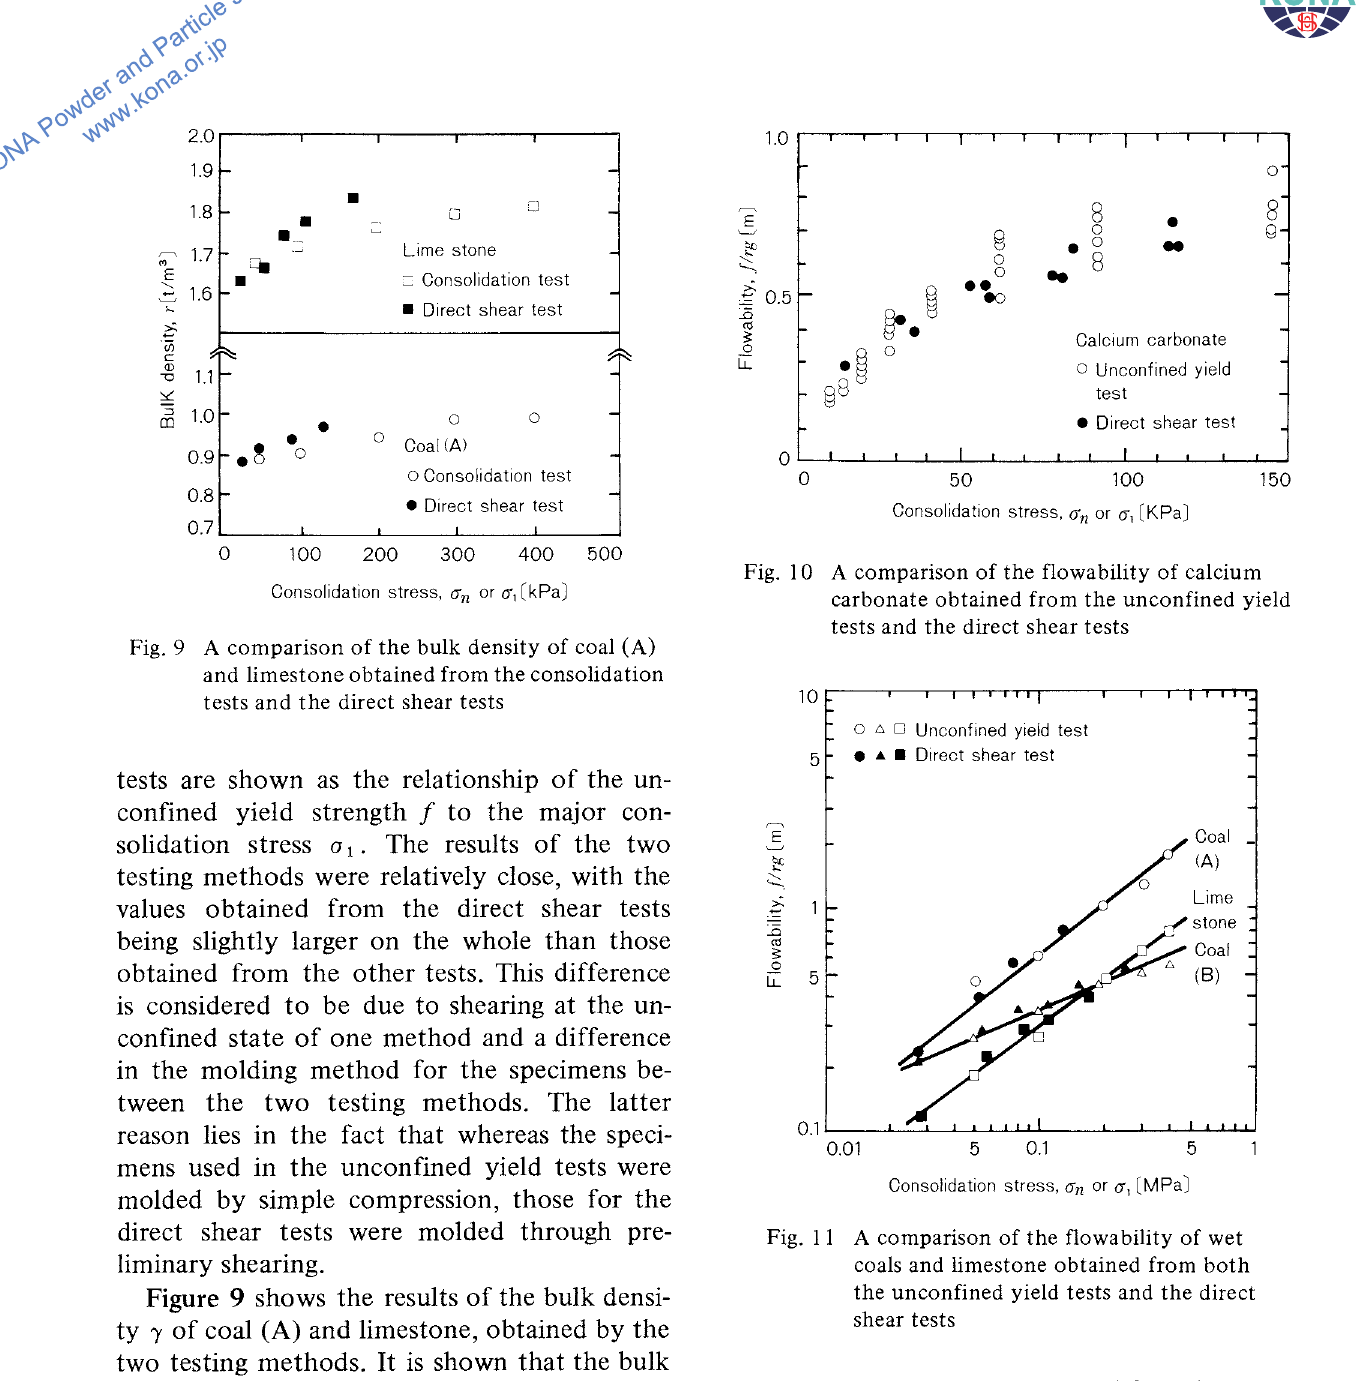
Fig. 10 A comparison of the flowability of calcium carbonate obtained from the unconfined yield tests and the direct shear tests